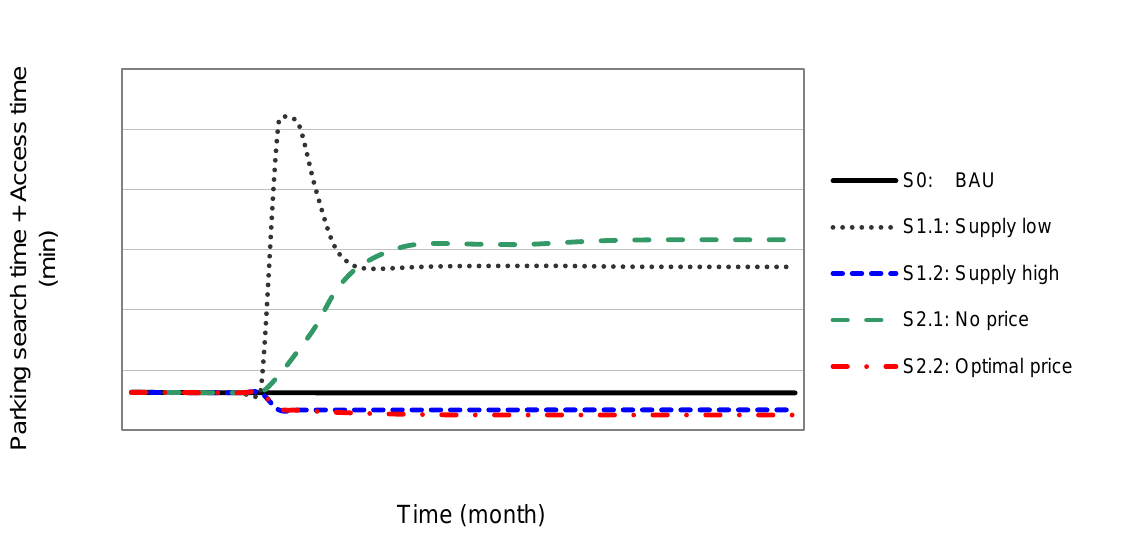
Figure 7. Parking search time results Table 2. Indicator values at equilibrium under different policy